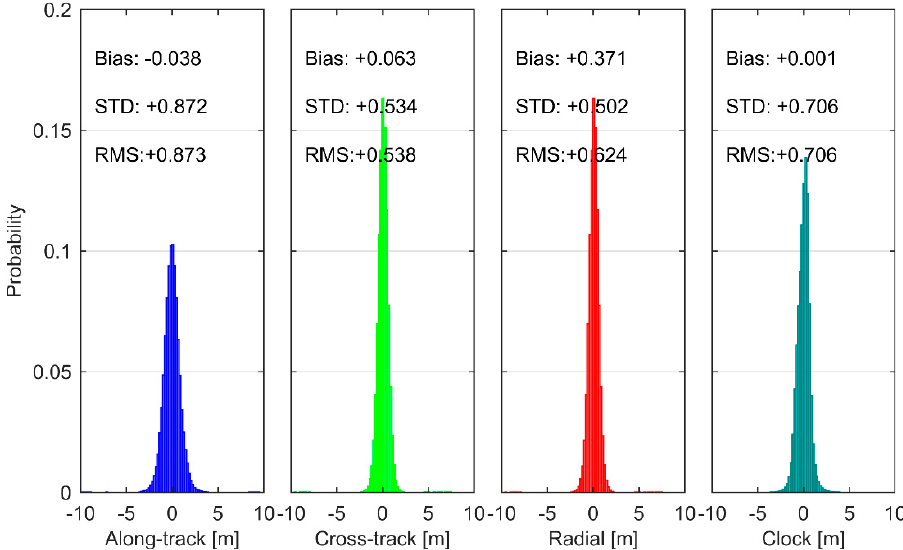
Figure 11. The distribution of SBAS-derived orbit and clock errors for SDCM PRN 140.